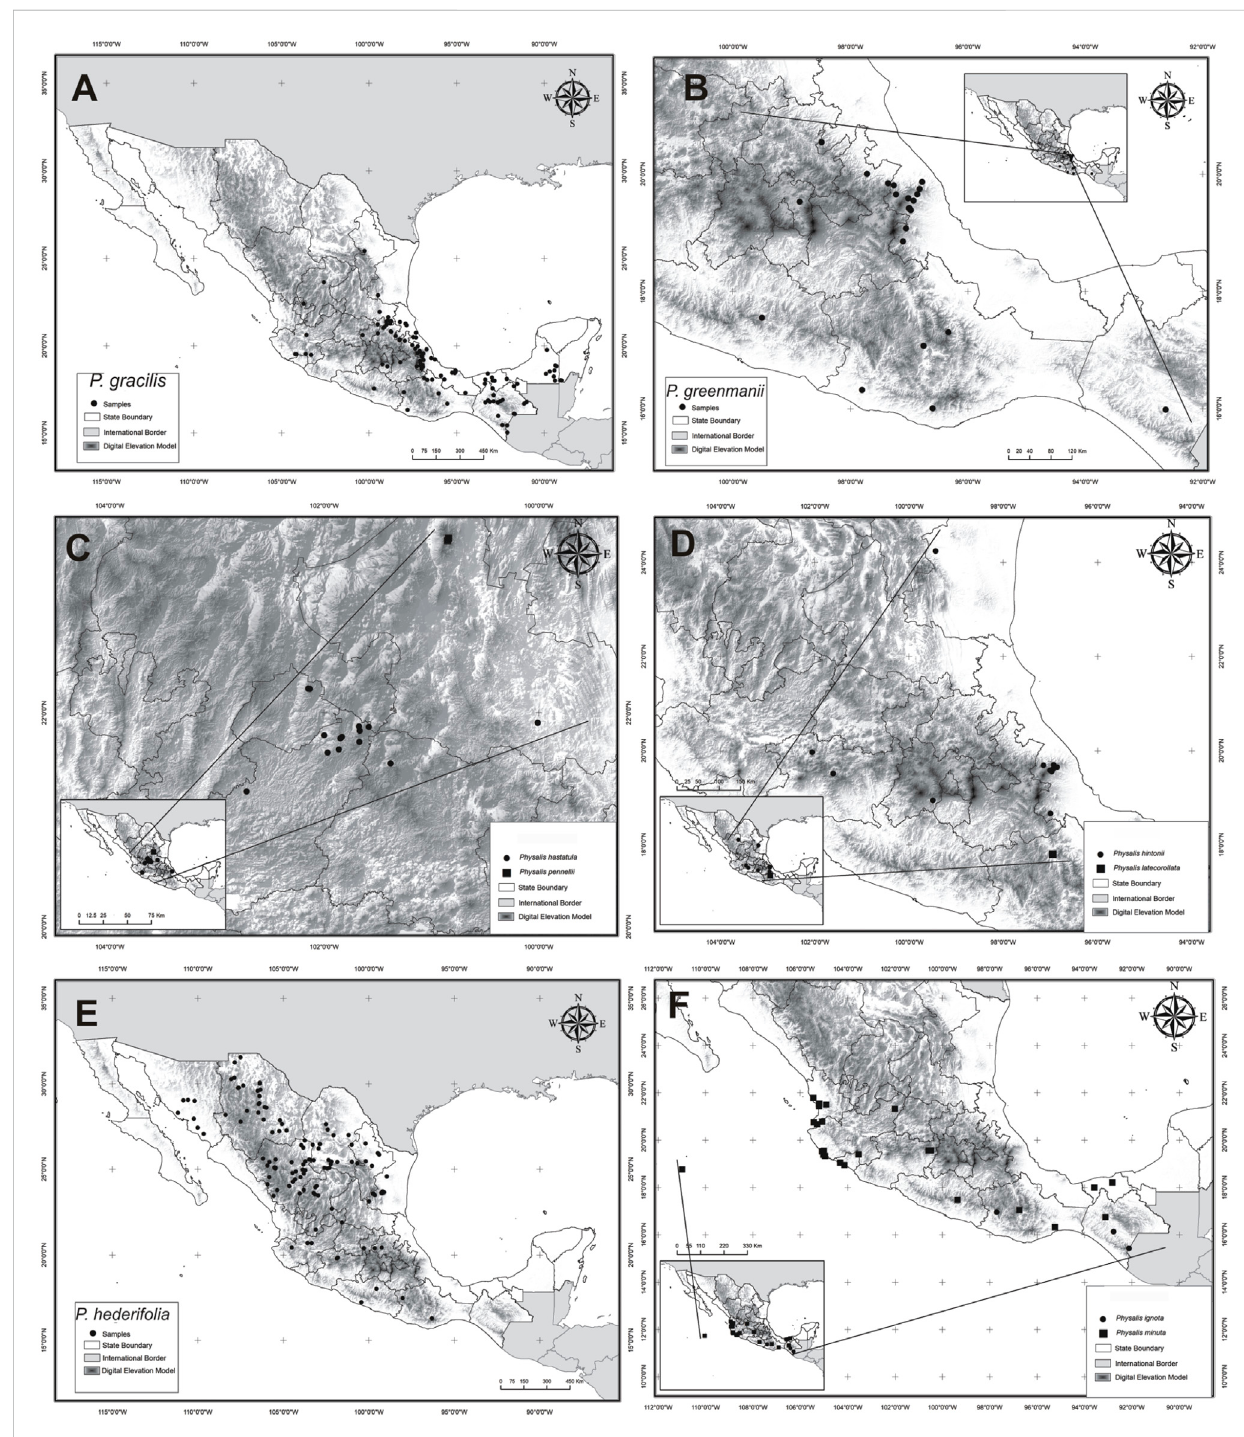
glabrous 5-angled fruiting calyx, and peduncles up to 3.2 cm